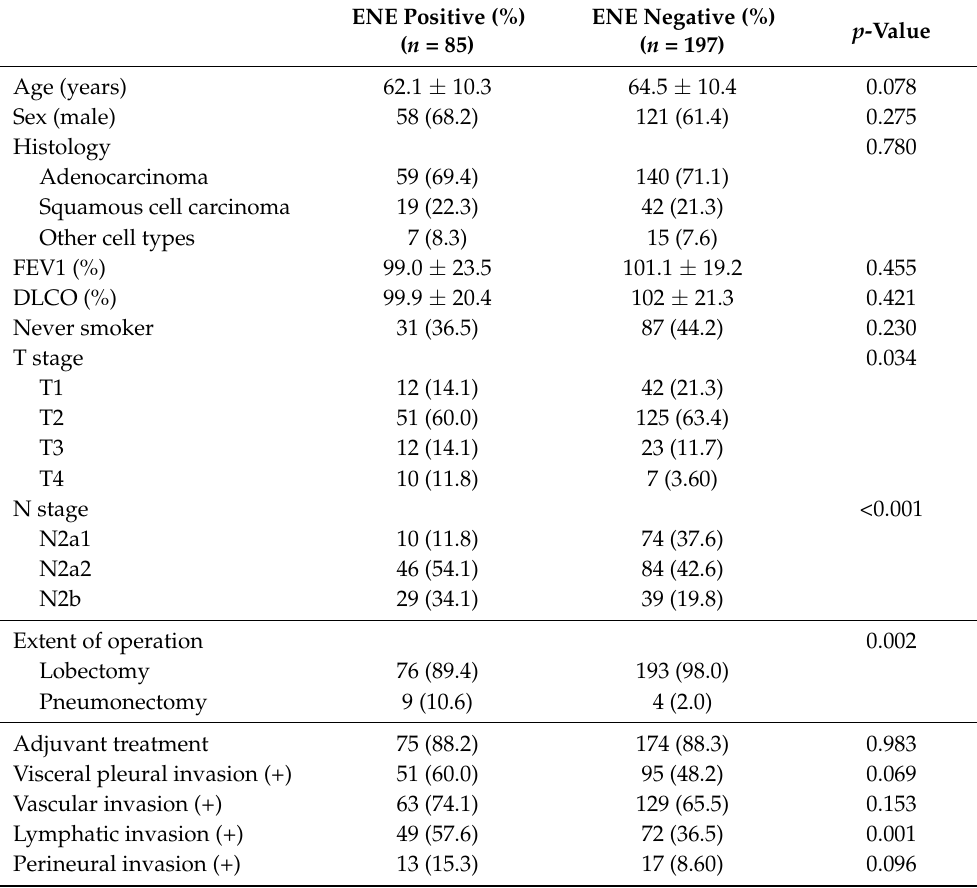
Table 1. Patients’ clinical characteristics depending on status of extranodal